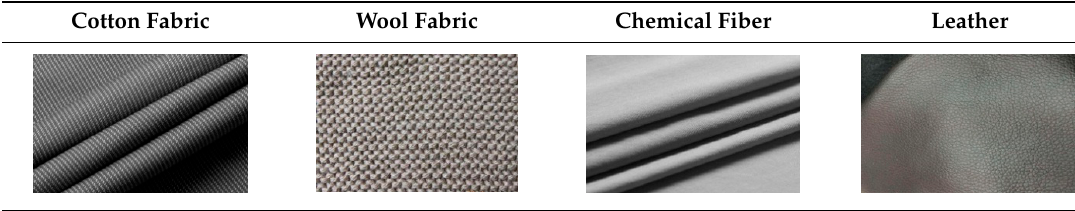
Table 1. The 4 material experimental samples of the train seat.